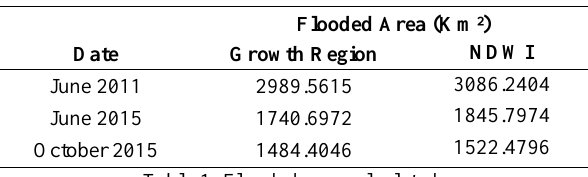
Table 1: Flooded area calculated.